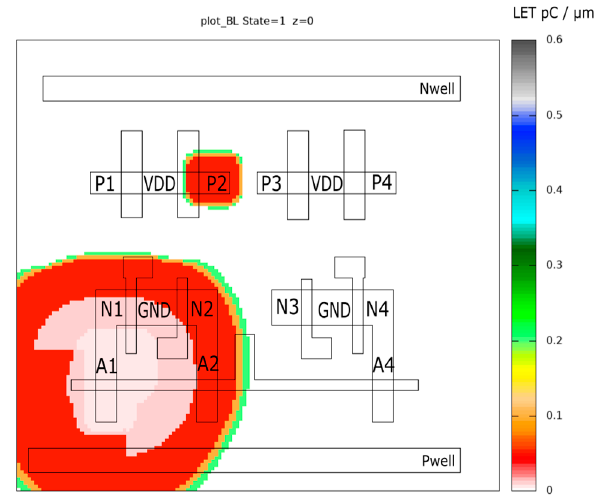
Figure 21. TFIT simulation sensitivity distribution with all ‘0’ stored data pattern.